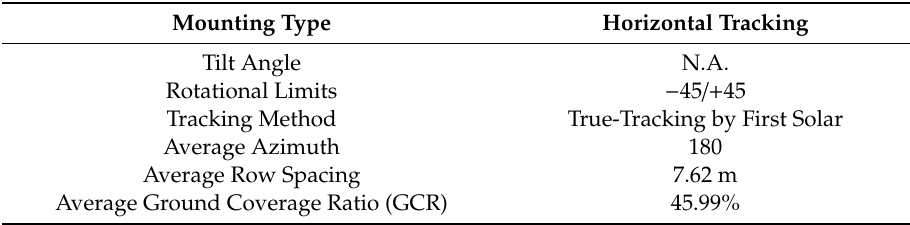
Table A1. Preliminary configuration of the PV array used for